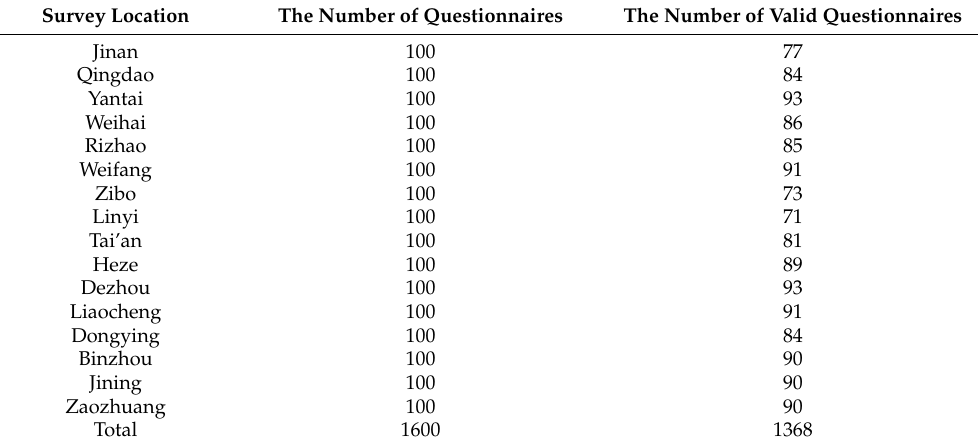
Table 1. Geographical Distribution of Samples.